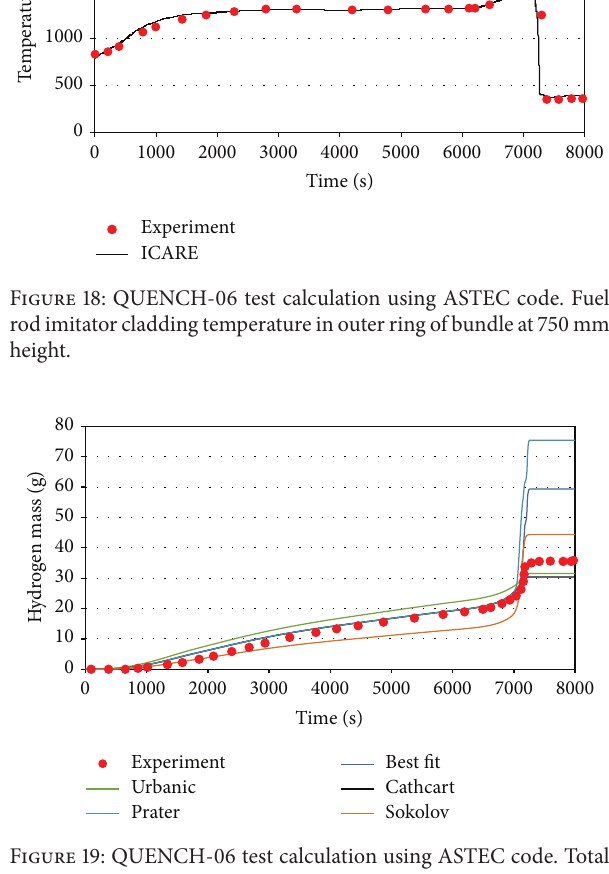
Figure 19: QUENCH-06 test calculation using ASTEC code. Total hydrogen